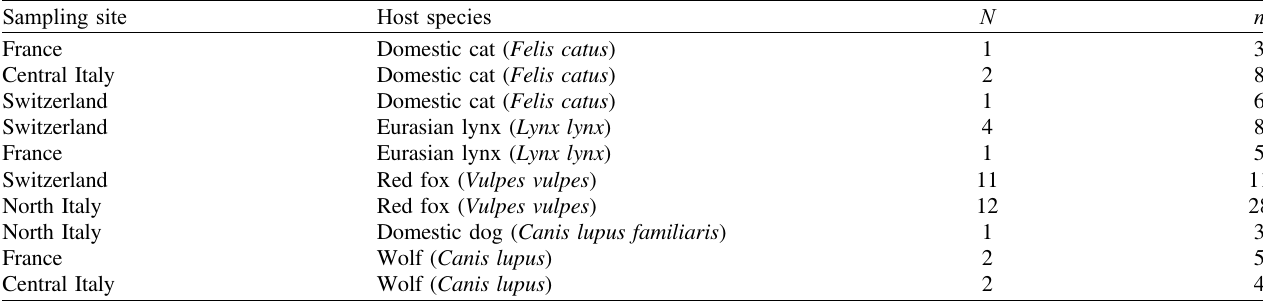
Table 2. Origin and sample size of the animals affected by sarcoptic mange included in this study. Sampling site